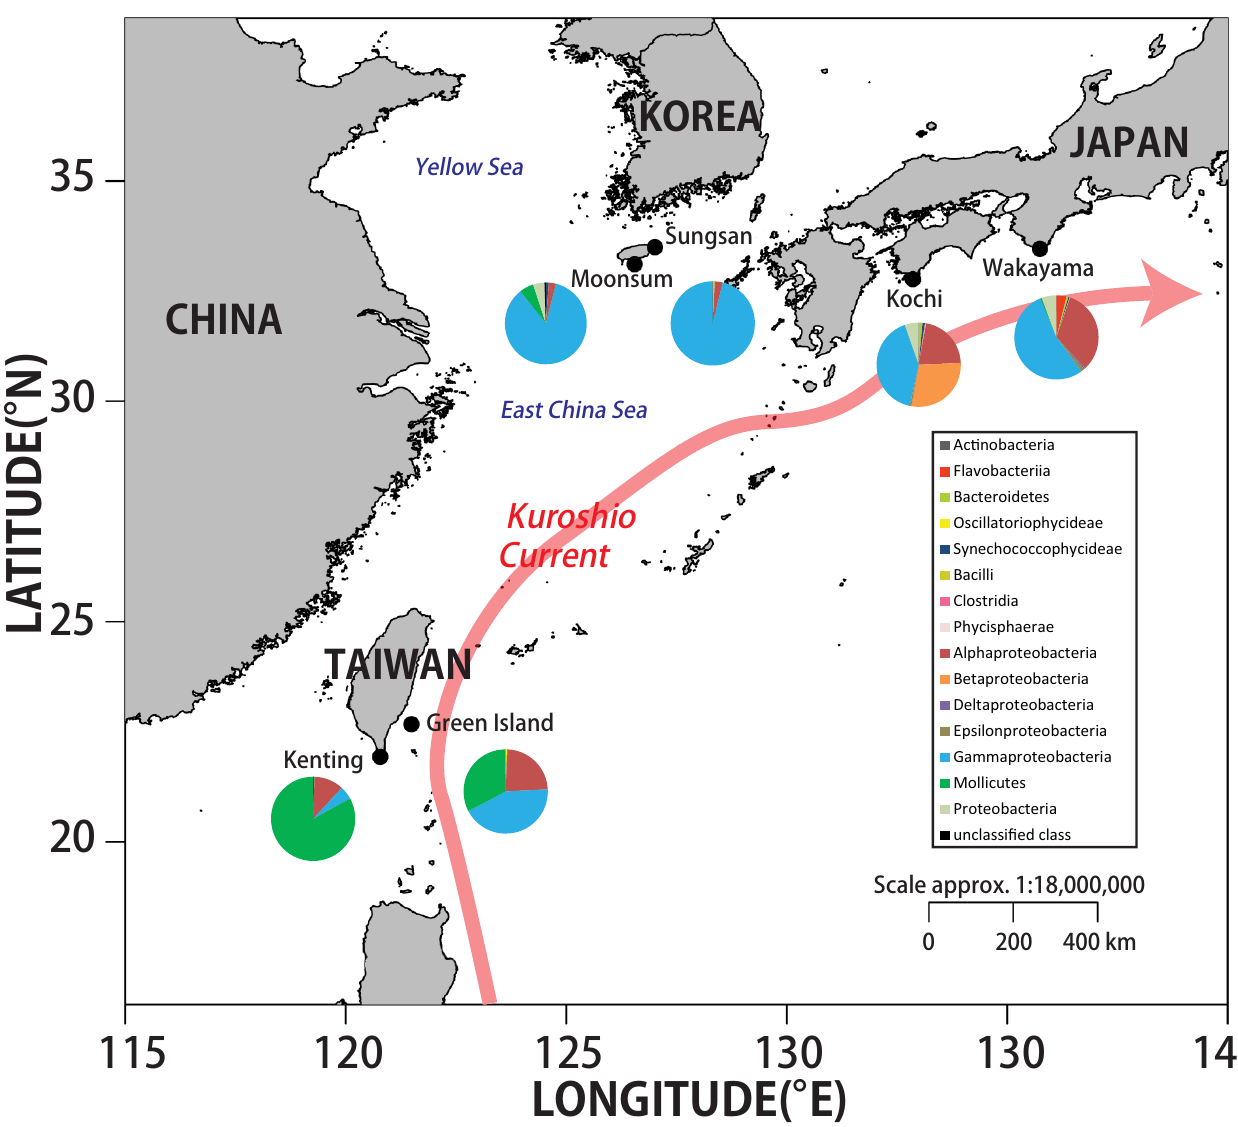
Fig 1. Relative abundance of major bacterial taxa in the soft coral Scleronephthya gracillimum from various locations. Each pie chart indicatesbacterialcomposition in S . gracillimum from a specific location.The map was created in R 3.2.3 (R Core Team 2015; https://www.R- project.org) using the maptoolspackageand spatial data freely availableon the DIVA-GIS website